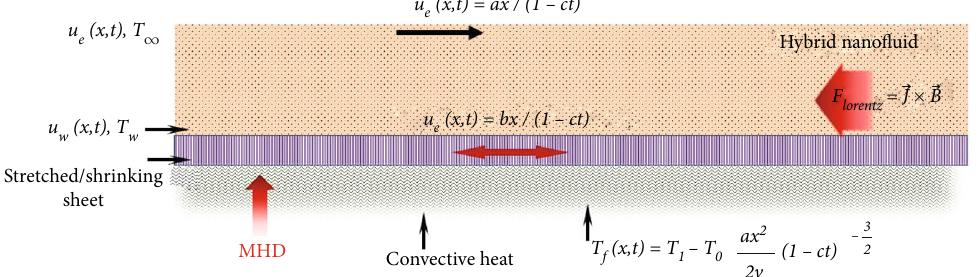
Figure 1: Schematic diagram of the 2D fl ow past a stretching/shrinking